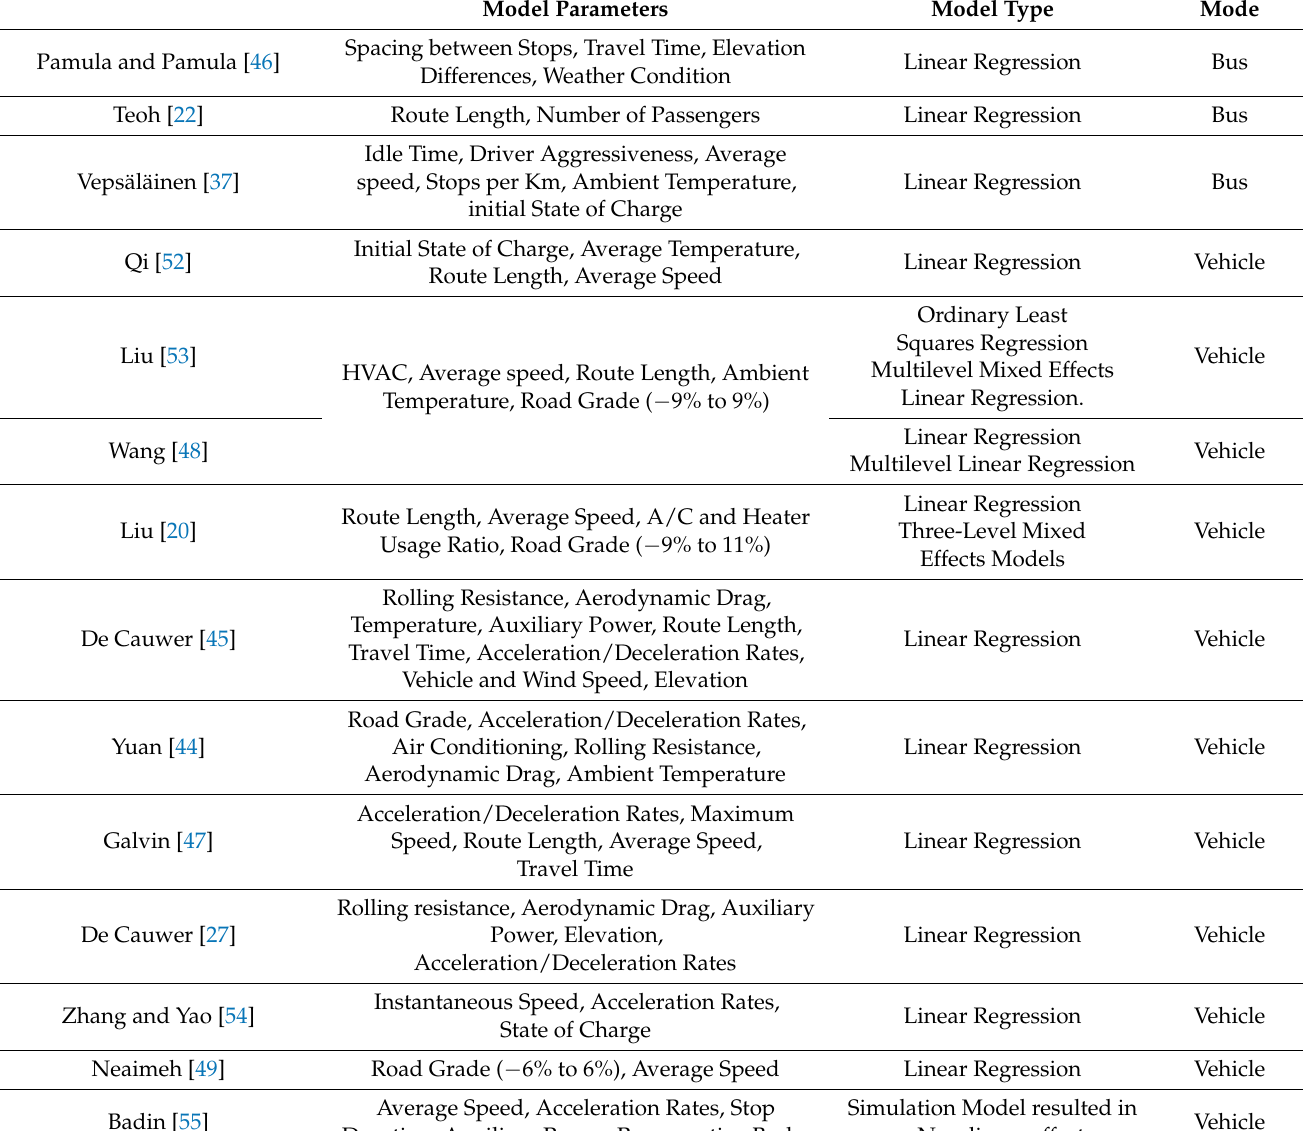
Table 2. A concise list of regression models used to predict energy consumption for BEBs and